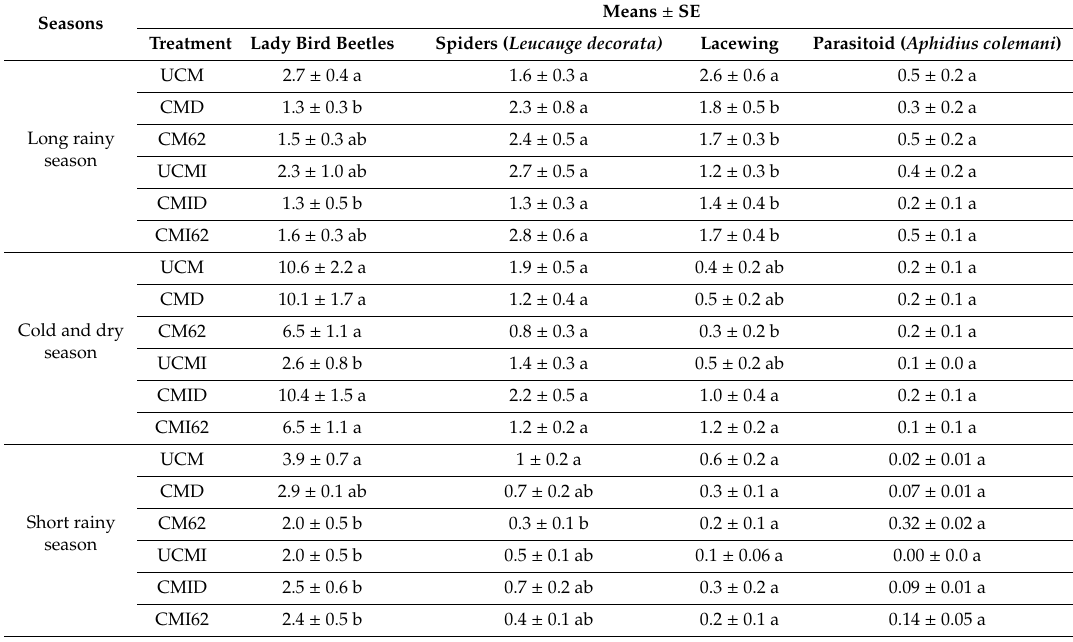
Table 1. Beneficial arthropod density recorded in the various treatments during the three seasons. Seasons